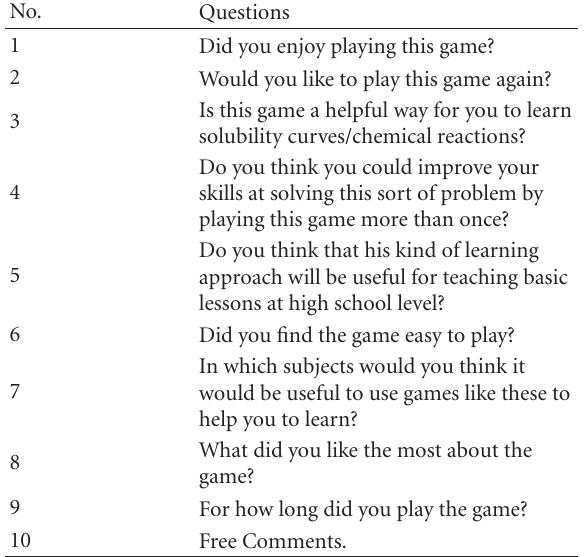
Table 4: List of questions after playing the game. No.